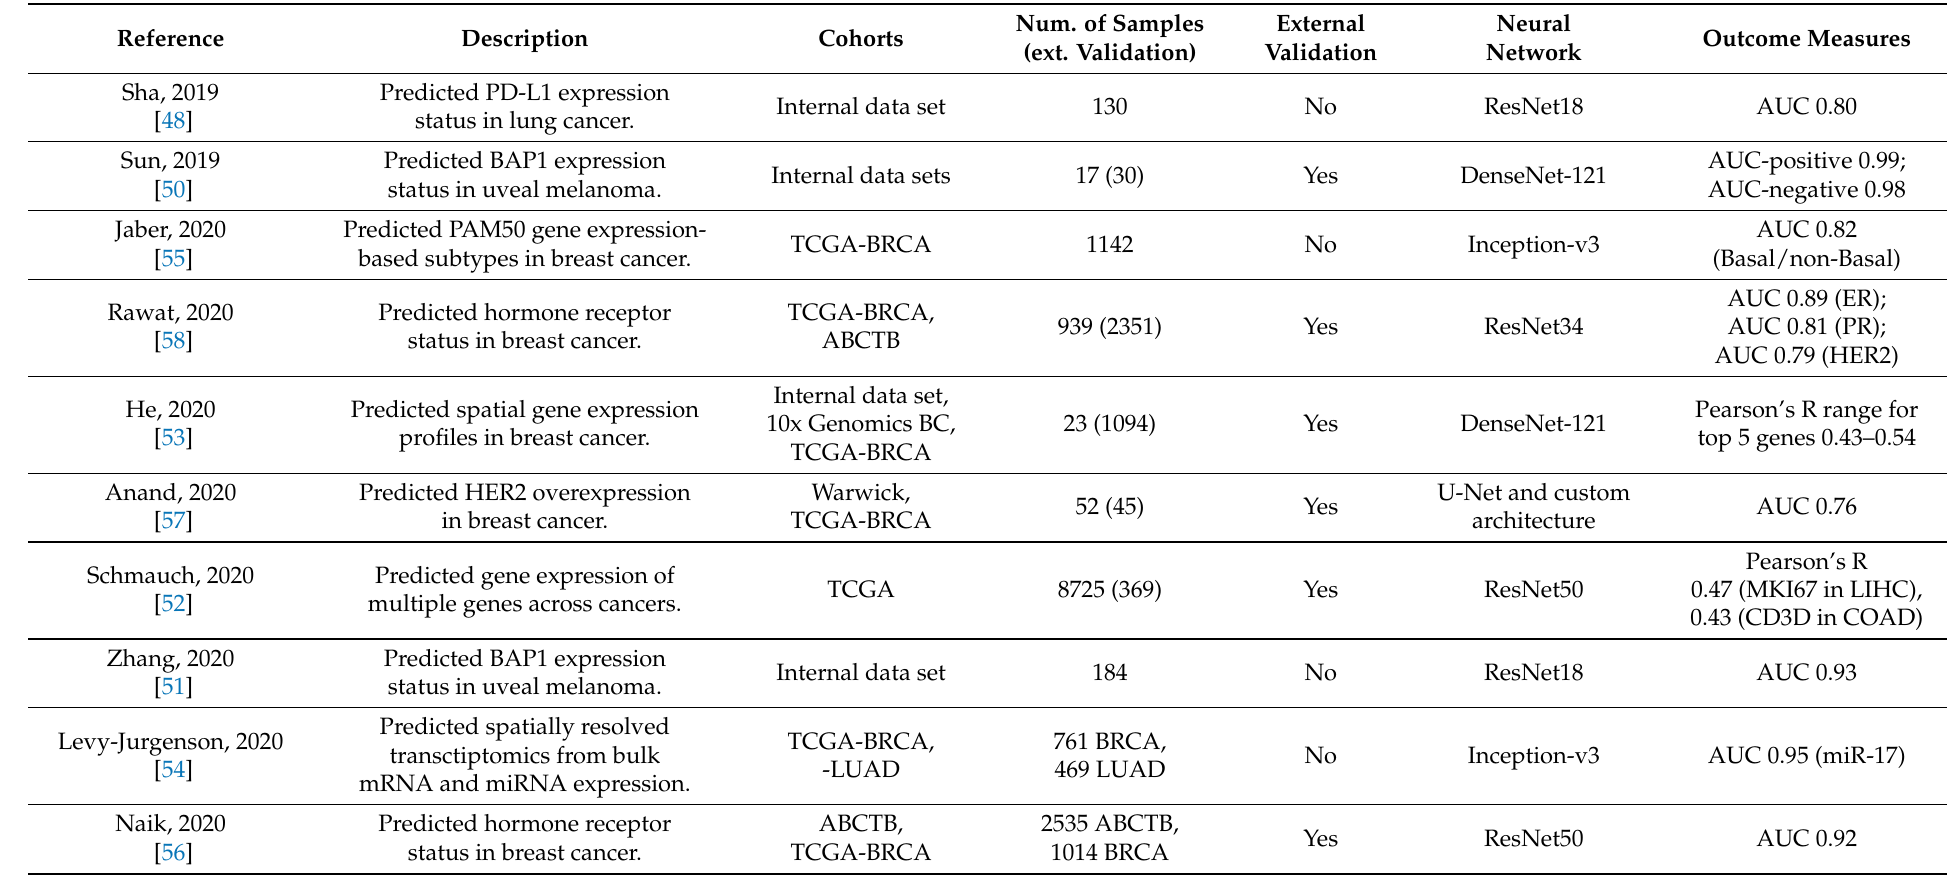
Table 2. Comparison of studies aimed at predicting gene expression/hormone receptor status from digitised histopathology slides using deep